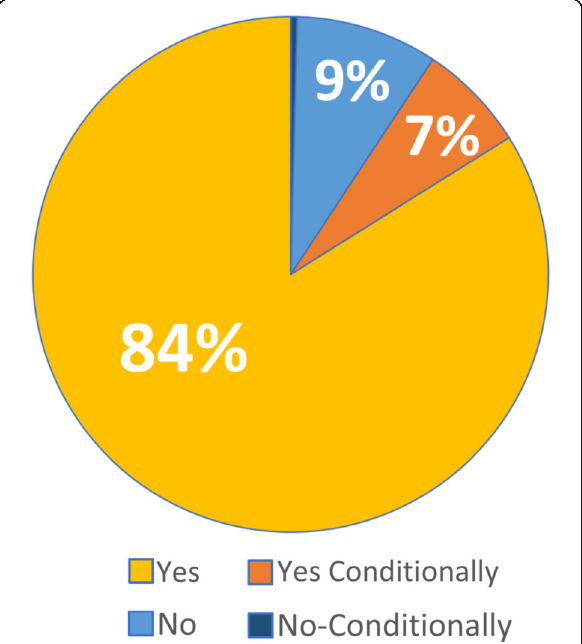
Fig. 12 Should teachers use video when classes are